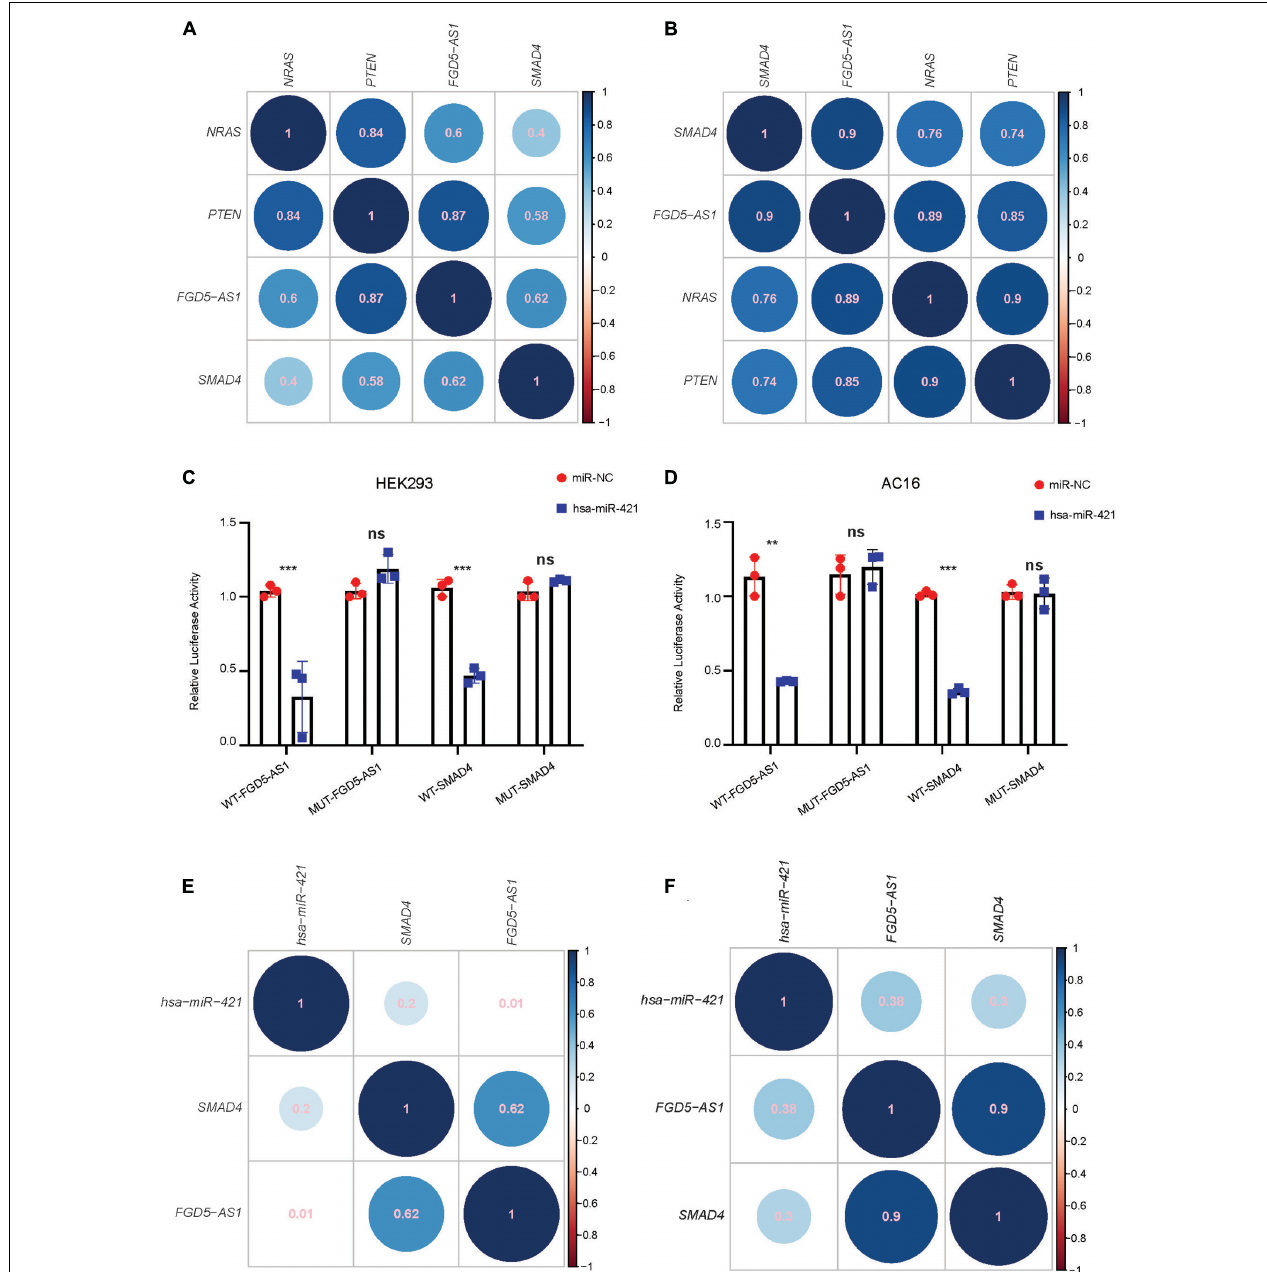
FIGURE 2 | FGD5-AS1 competing endogenous RNA (ceRNA) mechanism validation. The correlation coefficients between FGD5-AS1 and its ceRNA targets for our dataset (A) and the GEO: PRJNA156781 dataset (B) are shown. For lncRNA FGD5-AS1 and mRNA SMAD4 , hsa-miR-421 was validated in the HEK 293 (C) and AC16 (D) cell lines, respectively. The correlation coefficients between hsa-miRNA-421 and FGD5-AS1 / SMAD4 in our dataset (E) and the GEO: PRJNA156781 dataset (F) are also shown. n.s., not significant; The number of asterisks indicated the corresponding statistical significance ( p-value ). * p < 0.05; ** p < 0.01; *** p <